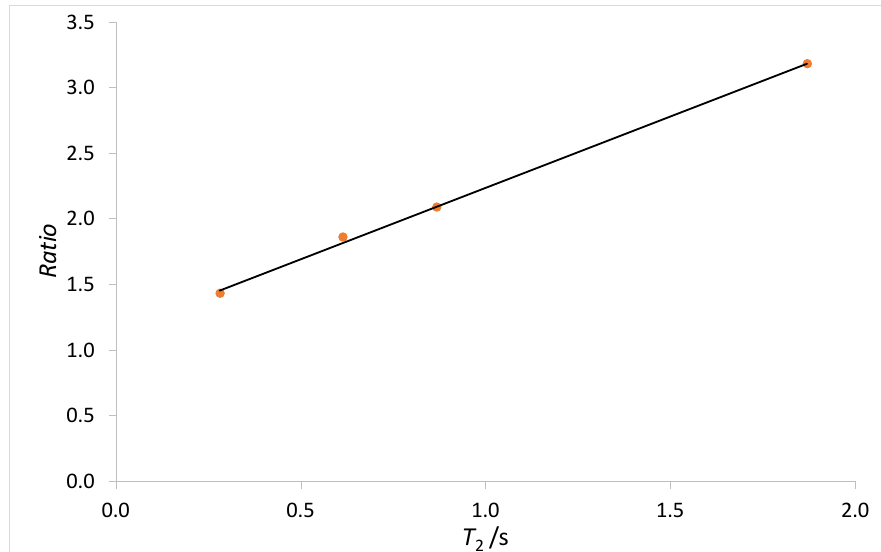
Figure A1. Plot of the ratio ( R ), between the T 2 relaxation time obtained from CPMG and RARE experiments, vs. T 2 obtained from RARE sequence. The black line represents a linear fit of the